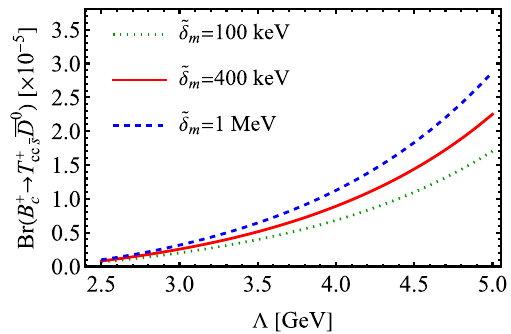
¯ D 0 via the cc ¯ s